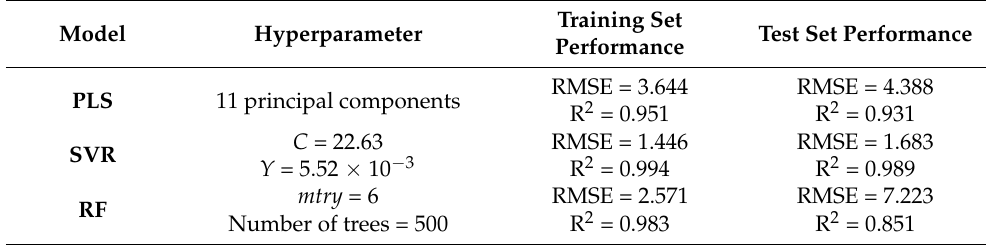
Table 2. Results obtained for each regression method applied in the quantification of the